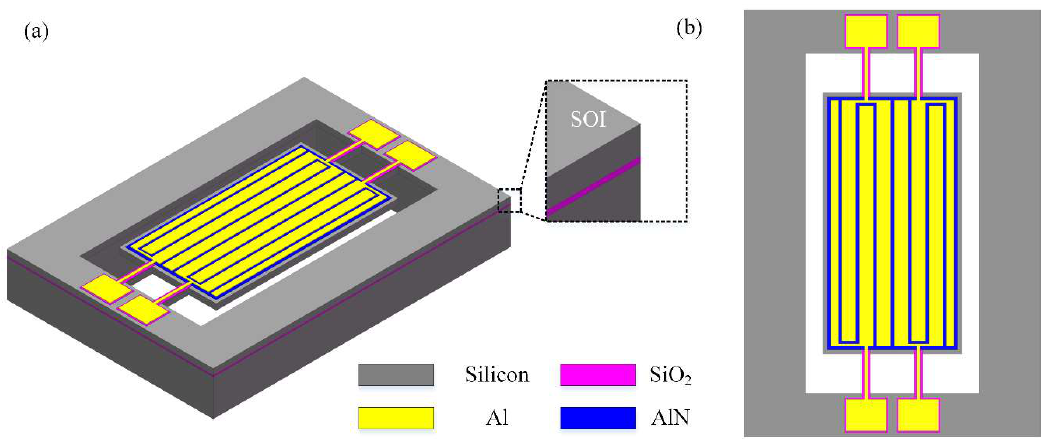
Figure 1. Schematic view of the designed thin-film piezoelectric-on-silicon (TPoS) resonator. ( a ) 3-D side view illustration of the resonator. The right inset image shows a high-magnification view of the SOI (i.e., silicon-on-insulator) substrate. ( b ) Vertical view of the resonator. This new design of the resonator operating in differential-in differential-out (DIDO) configuration reduces the insertion loss and suppresses the feedthrough.